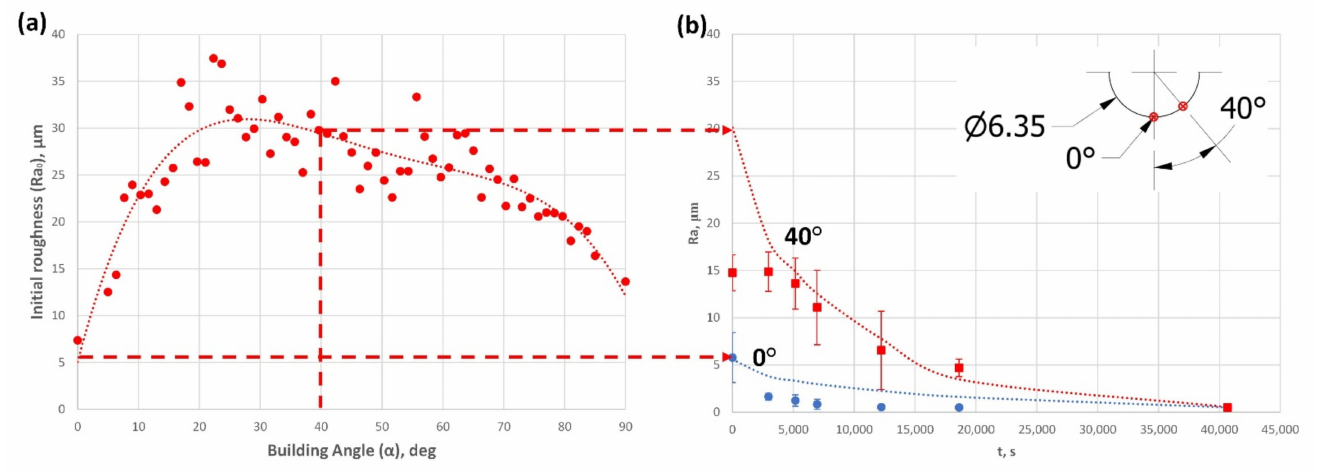
Figure 22. S-shape: ( a ) initial roughness, Ra 0 ( α ) ; ( b ) roughness evolution, Ra ( t ) : experimental (Exp) vs. modelling